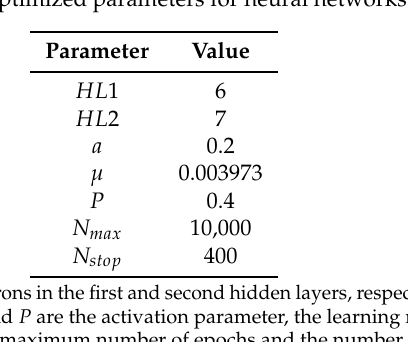
Figure 2. General architecture of the neural network. HL1 and HL2 refer to the first and second hidden layers, respectively, and W1, W2, and W3 refer to the weights connecting the different layers. Table 3. Optimized parameters for neural